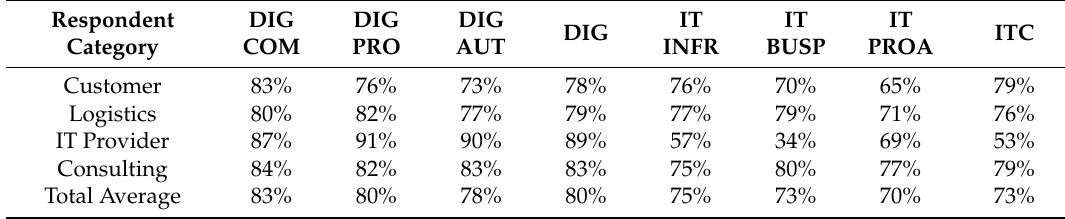
Table 4. Results concerning Digitalization and IT